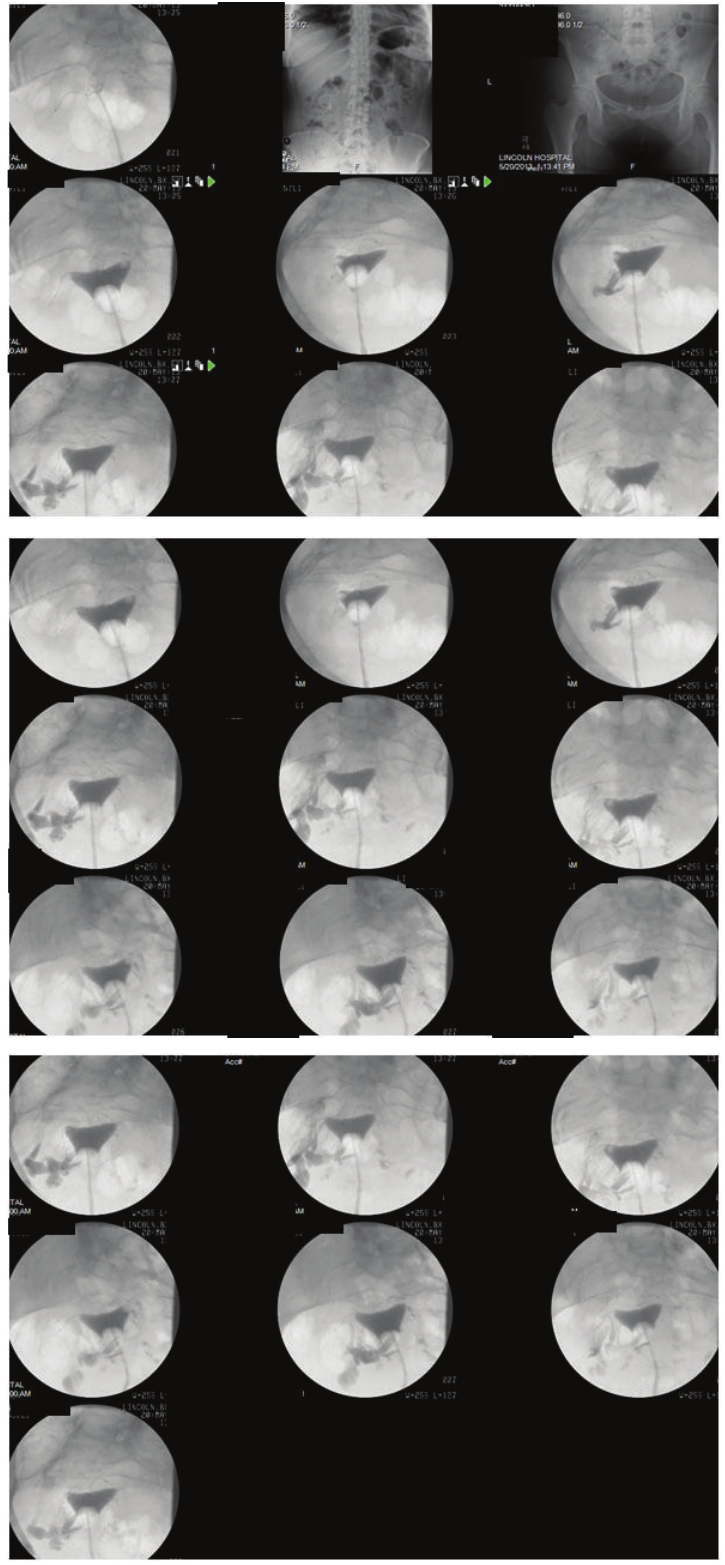
Figure 1: Patient Number 1, hysterosalpingogram DX (HSG) on 5/23/13, showing proper Essure placement with bilateral tubal occlusion with no spillage of the